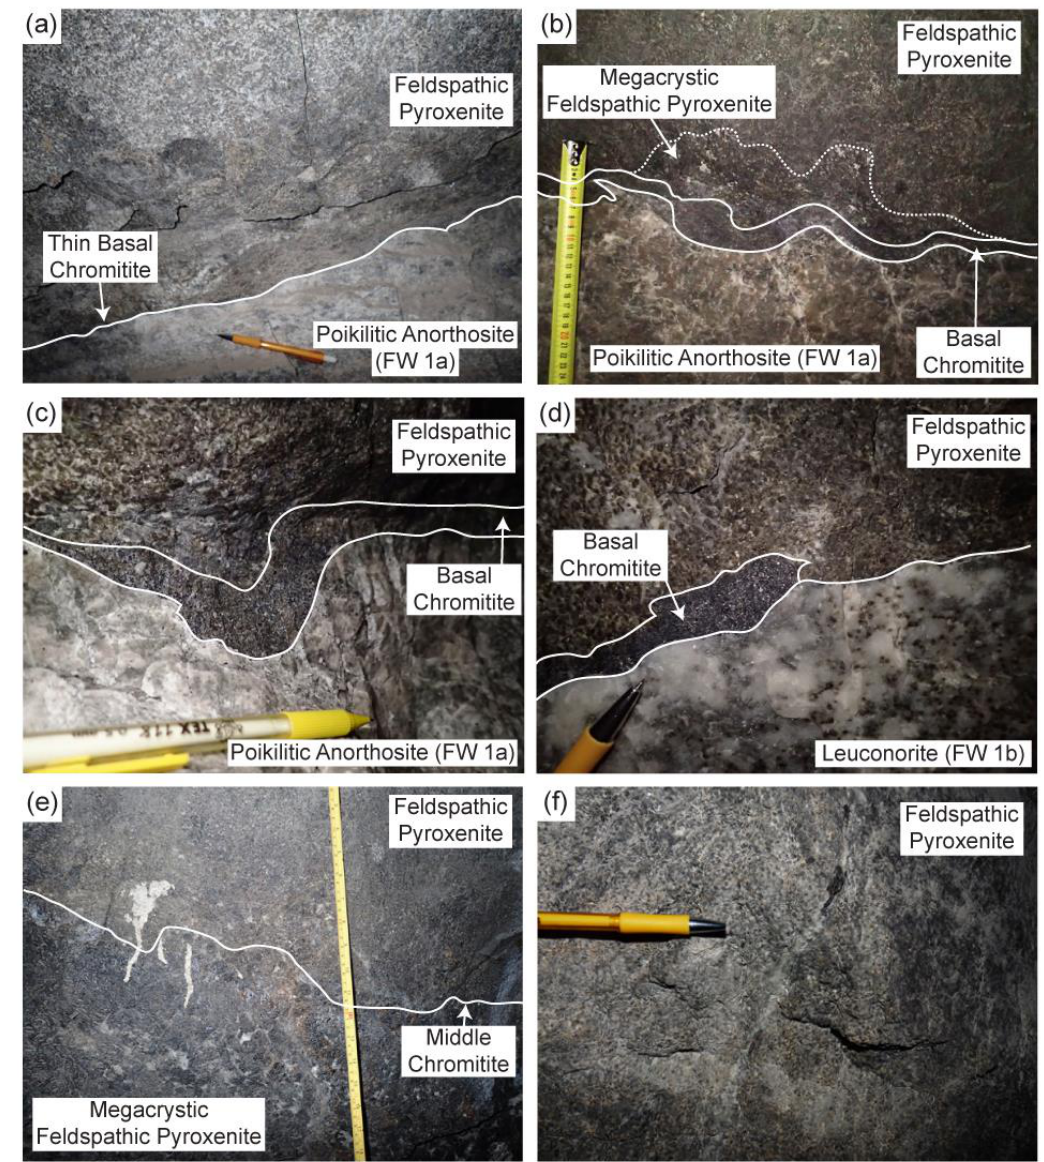
Figure 4. ( a ) Relatively planar basal contact of Merensky Unit with thin basal chromitite, note that the megacrystic feldspathic orthopyroxenite is absent; ( b ) Undulating basal contact of the Merensky Unit with “patchy” megacrystic feldspathic orthopyroxenite; ( c ) Basal chromitite thickens within “dimple”; ( d ) Discontinuous basal chromitite at the Merensky Unit—Footwall contact; ( e ) Middle chromitite at contact between megacrystic feldspathic orthopyroxenite and feldspathic orthopyroxenite; ( f ) Medium-grained feldspathic orthopyroxenite within the Merensky Unit; for scale, the pencil is 14 cm long.